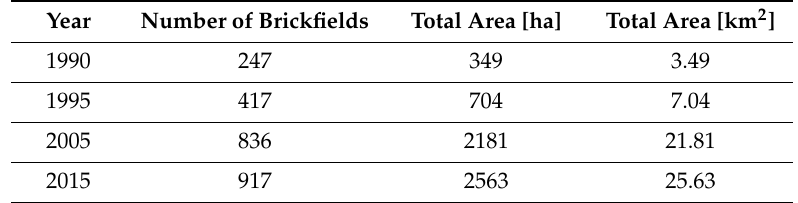
Table 1. Spatial expansion of brickfield locations between 1990 and 2015 in the Dhaka